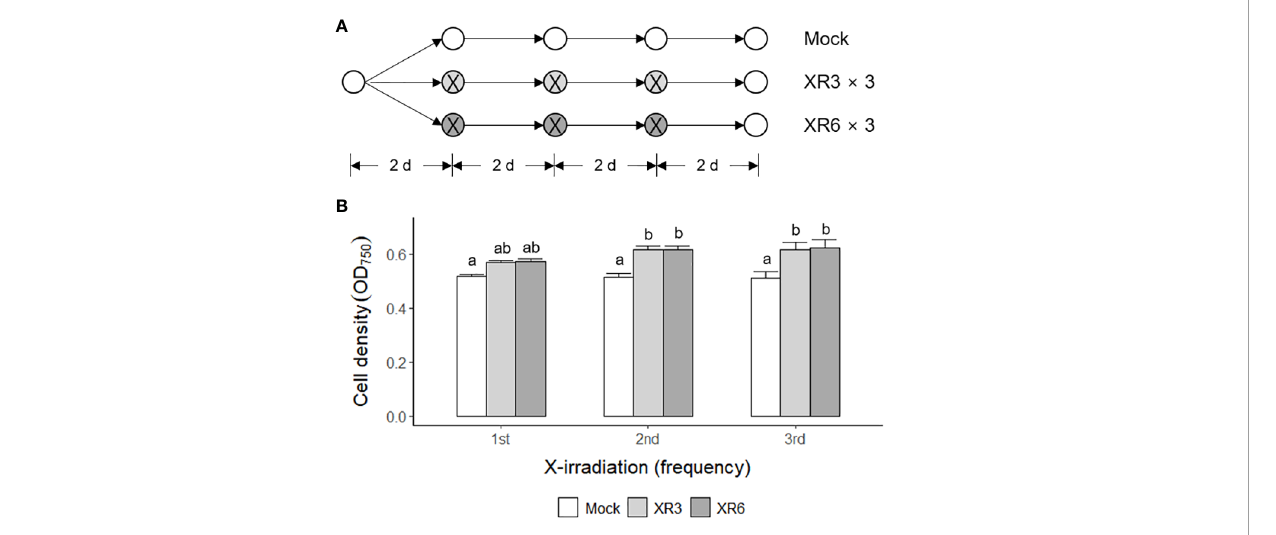
FIGURE 2 Enhanced growth stimulation of C. reinhardtii cells by repetitive X-irradiation with 3 or 6 Gy. XR3 and XR6 represent X-rays of 3 and 6 Gy, respectively. (A) A schematic diagram of repetitive X-irradiation. The absorbed doses of 3 and 6 Gy, which increased the growth of C. reinhardtii cells, were repeatedly applied to the X-irradiated cells at 2-day intervals as described in the Materials and Methods section. The cultivation of the mock was initiated at a cell density of 0.05 OD 750 . The irradiated samples were subjected to post-irradiation cultivation with the equivalent volume of the mock to cumulate a difference in the growth rate after each X-irradiation. (B) Cell density (OD 750 ) of C. reinhardtii 2 days after single or repetitive X-irradiation. Data represent the mean ± standard error (SE) with n = 9 from three independent experiments. Different letters indicate signi fi cant differences at p < 0.05 (one-way analysis of variance followed by Tukey ’ s honestly signi fi cant difference